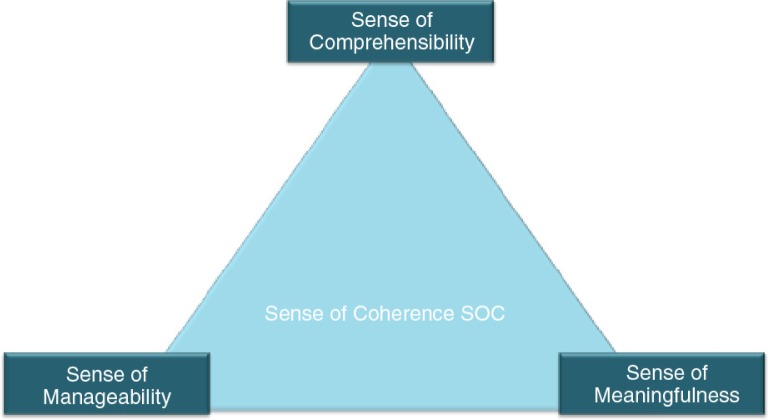
Dimensions of the Sense of Coherence (Antonovsky, 1987).